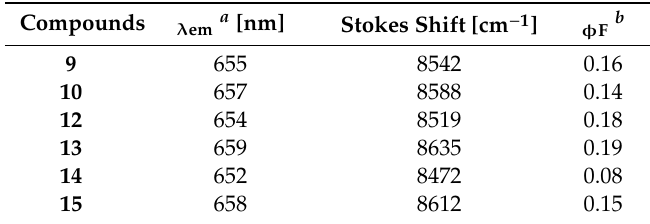
a —excitation at λ Soret , b —quantum yields against TPP